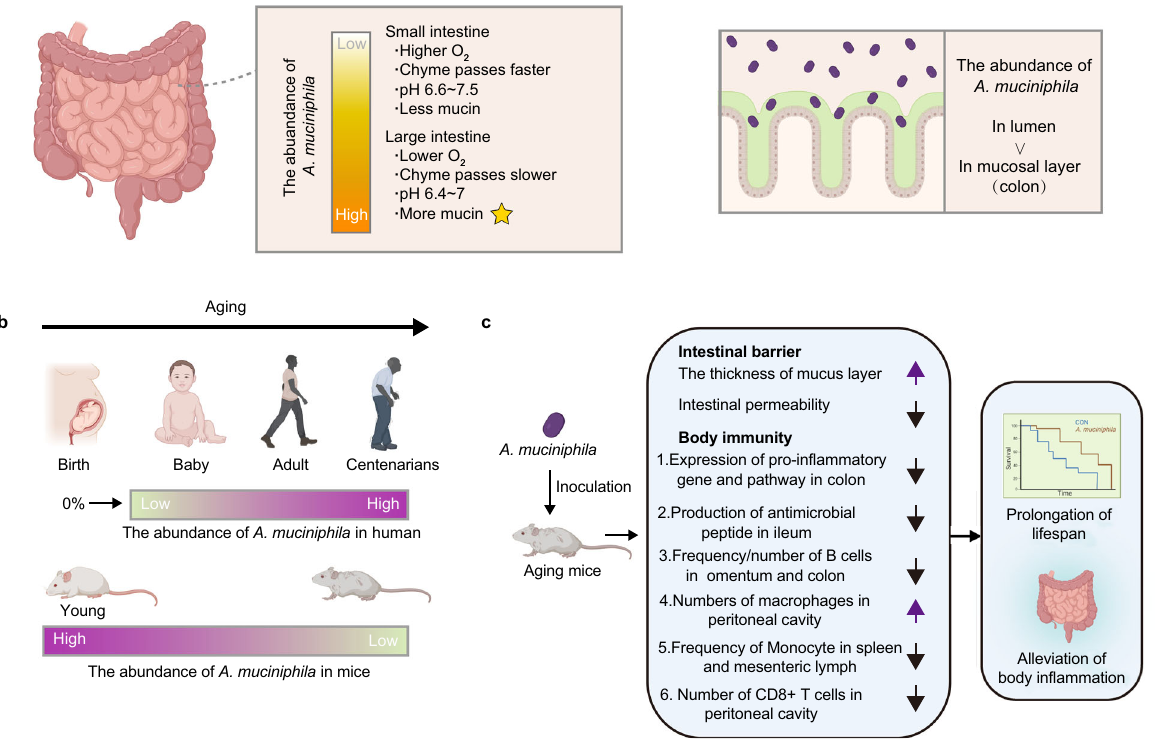
Fig. 1 The abundance and role of A. muciniphila with spatial and temporal change in the GIT. a The distribution of A. muciniphila along the GIT (small and large intestine) and in the lumen and mucosal layer. b The schematic diagram of A. muciniphila abundance changing with age in the human and mouse GIT. c The mechanisms of A. muciniphila ameliorating aging in mice. All fi gures are created with